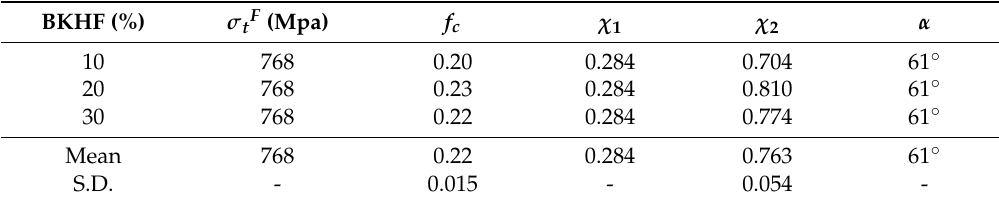
Table 3. Intrinsic tensile strength of the BKHF and micromechanics parameters for a modified rule of mixtures of the tensile strength of the composites. BKHF